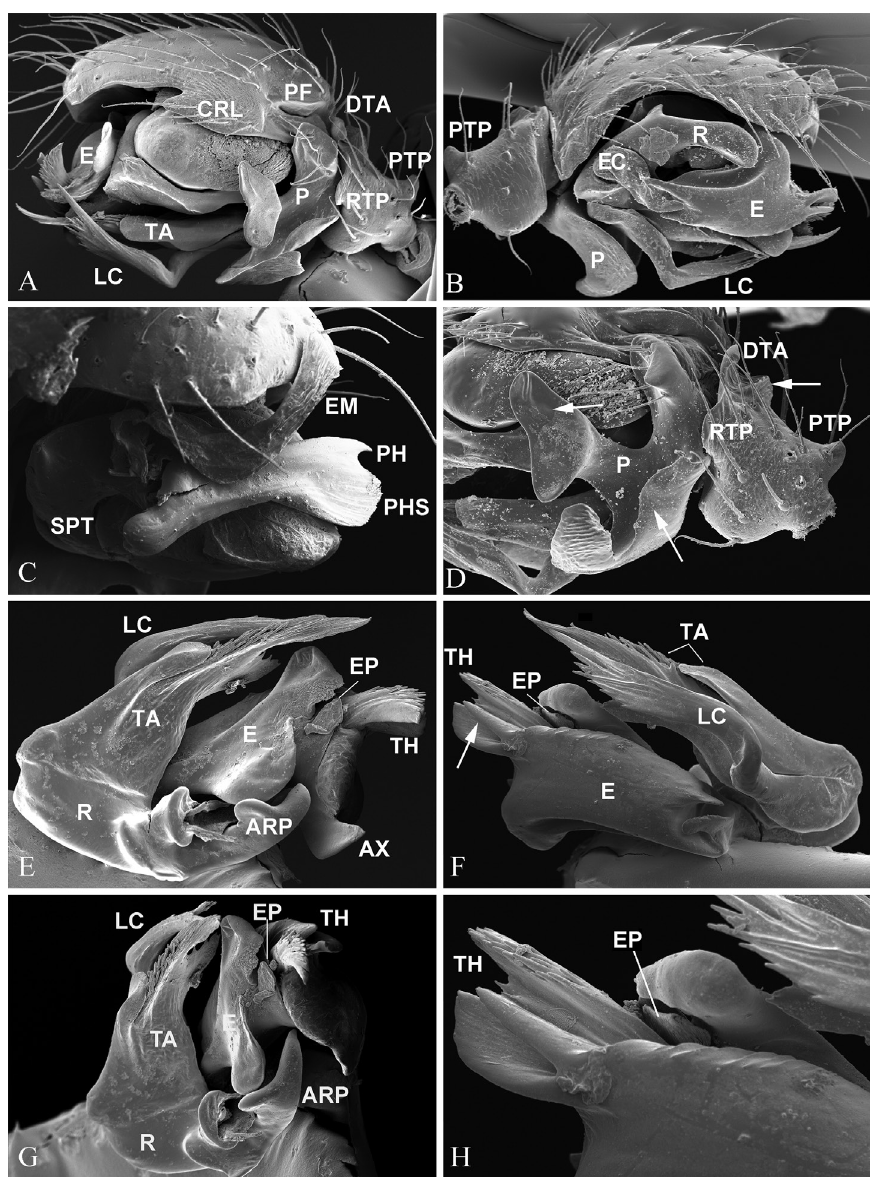
Figure 3. Nippononeta alpina comb. n., male palp. A retrolateral B prolateral C prolateral with embolic division removed D detail of A, arrows indicate serrated surface of DTA (upper right), median branch of paracymbium (upper left) and outer margin fold (lower) ( E–H ) embolic division E dorsal F ventral, ar- row indicates embolic spine G anterior H detail of F, shows hided EP. Abbreviations: ARP anterior radi- cal process; AX apex of embolus; CRL cymbial retrolateral lobe; DTA distal tibial apophysis; E embolus; EM embolic membrane; EP embolus proper; LC lamella characteristica; P paracymbium; PF posterior fold; PH pit hook; PHS pit hook sclerite; PTP proximal tibial process; R radix; SPT suprategulum; TA terminal apophysis; TH thumb of